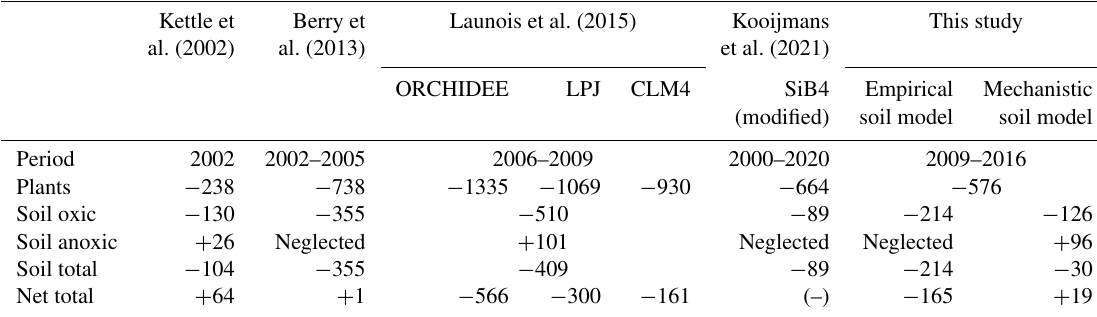
Table 3. Comparison of soil COS budget per year (GgSyr − 1 ). The net total COS budget is computed by adding all sources and sinks of COS (anthropogenic, ocean, biomass burning, soils, vegetation, atmospheric OH oxidation, and photolysis in the atmosphere) used to transport COS fluxes (Table 2). CLM: Community Land Model. SiB: Simple Biosphere